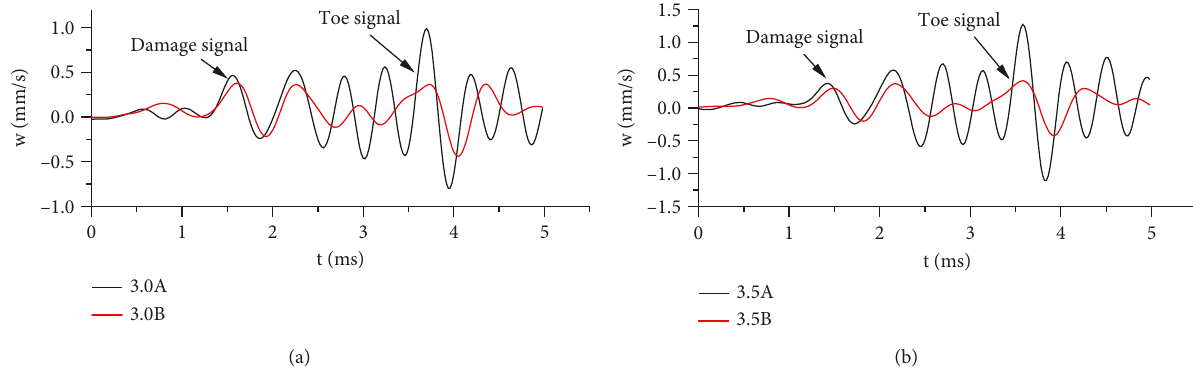
Figure 27: Upward velocities of different sensor locations. (a) Upward velocities of A velocities of A i and B i (sensor location Z s